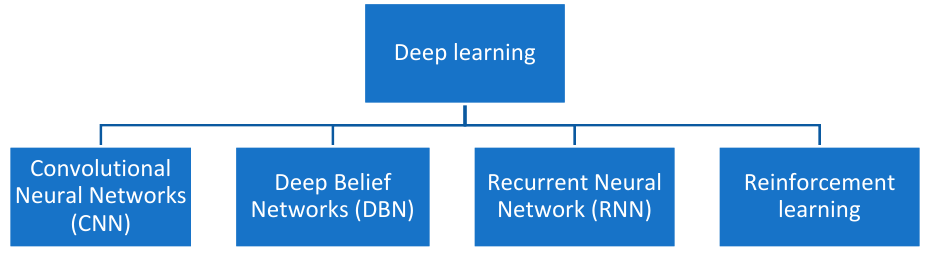
Figure 1. Deep learning-based COVID-19 diagnosis systems.